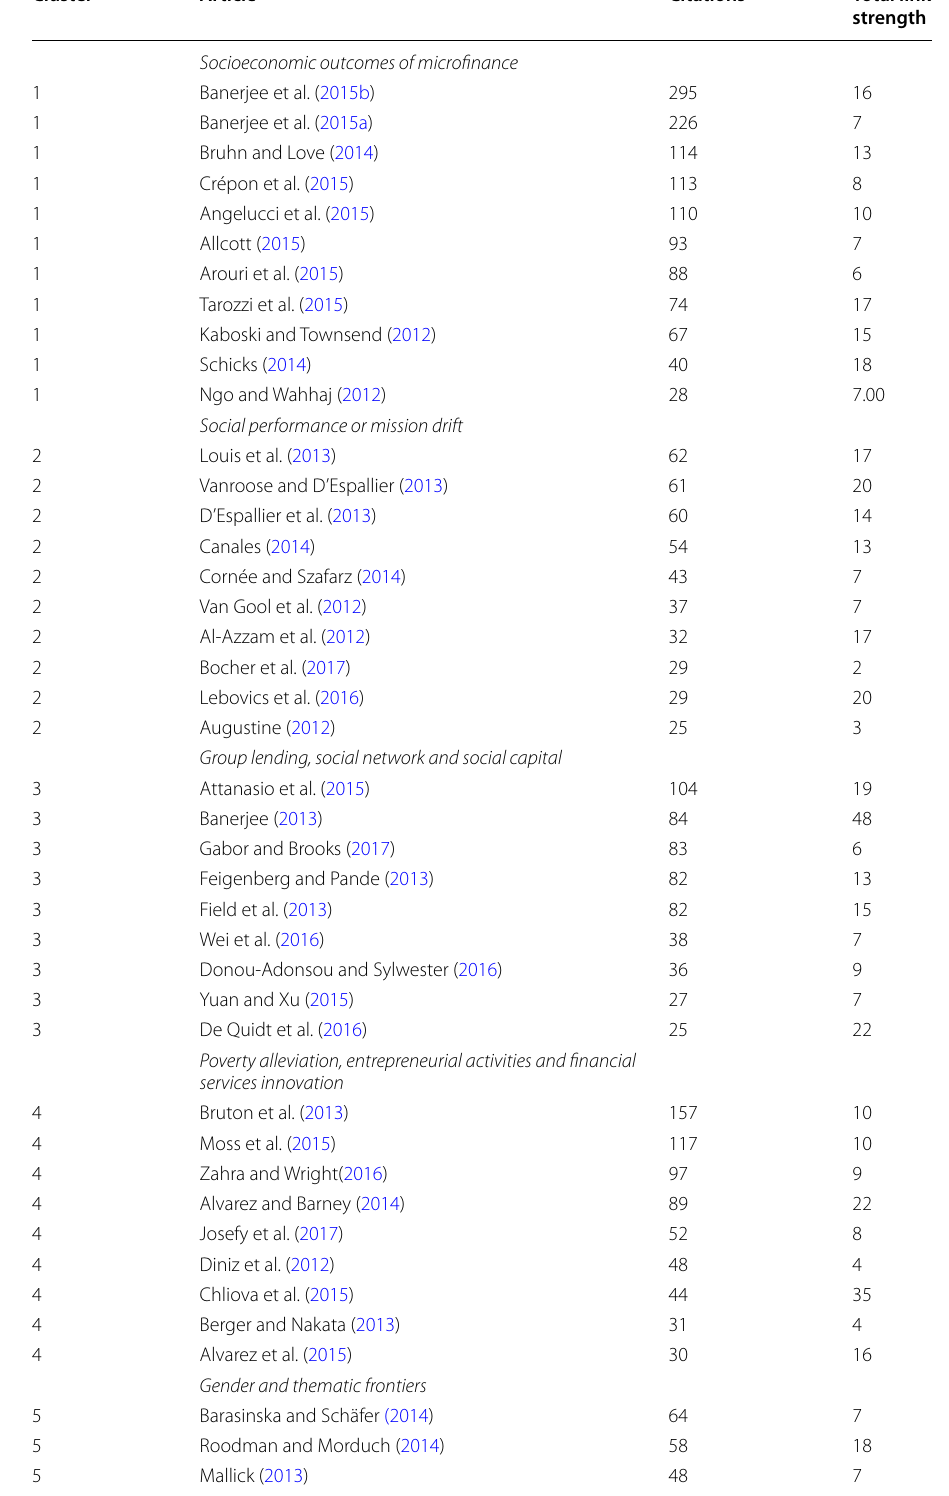
Table 9 Top articles in each cluster based on fractional counting method